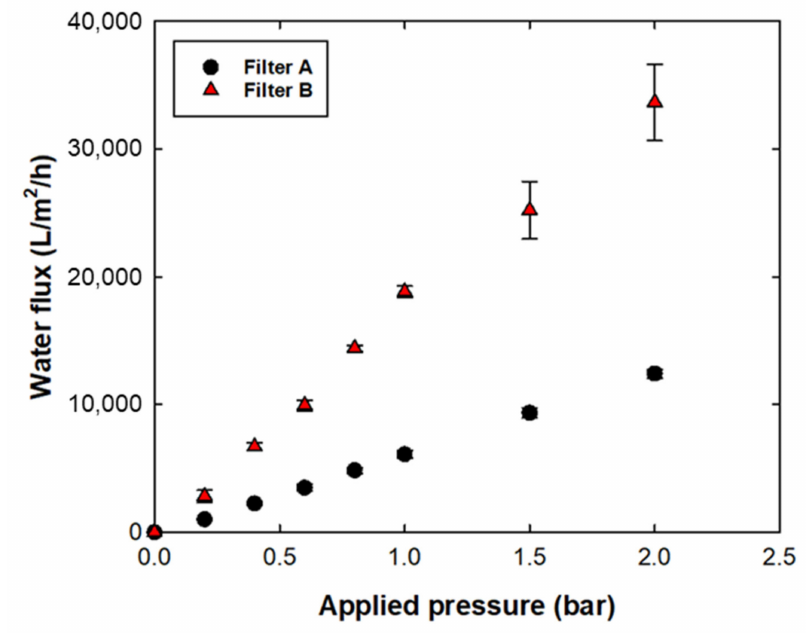
Figure 3. Water permeability of filters A and